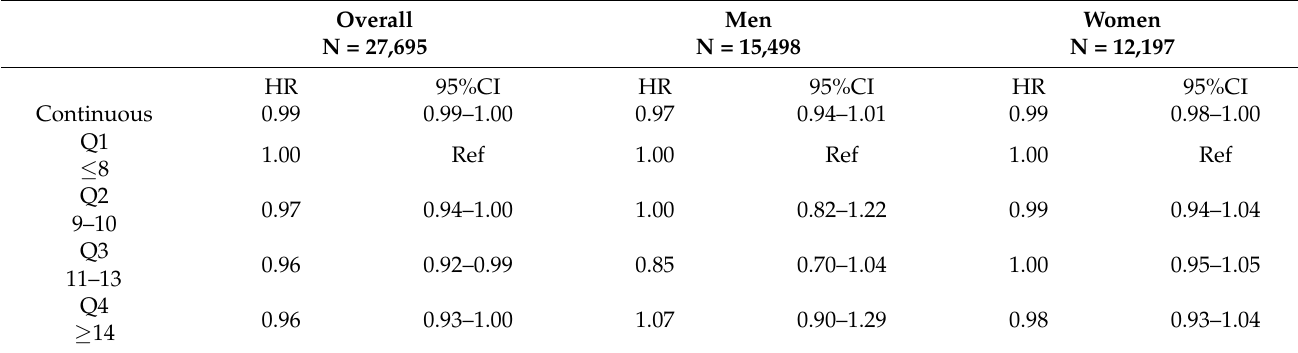
Table 2. Hazard ratios (HR) and 95% confidence intervals (CI) for continuous and quartiles of serum total bilirubin (STB), by overall cancer risk and stratified by